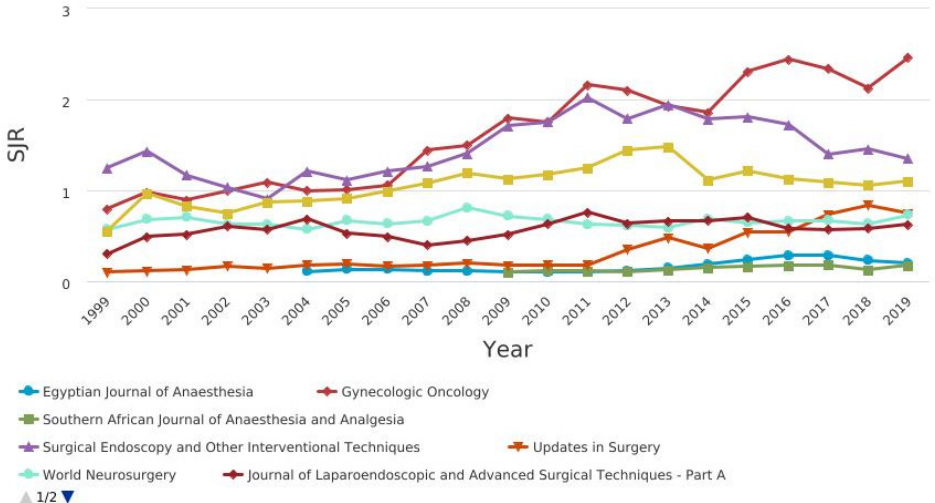
Figure 4. CiteScore of pain, anesthesia, and surgery journals.